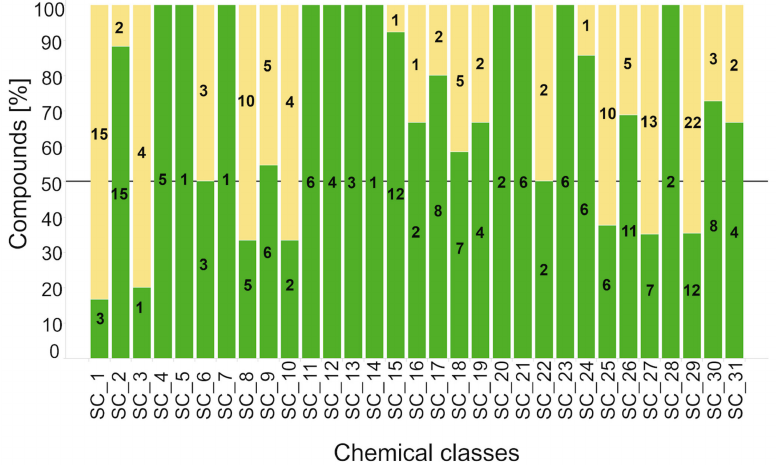
Figure 6. Stacked bar chart showing percentage of true hits (green) and interfering compounds (yellow) within each chemical class